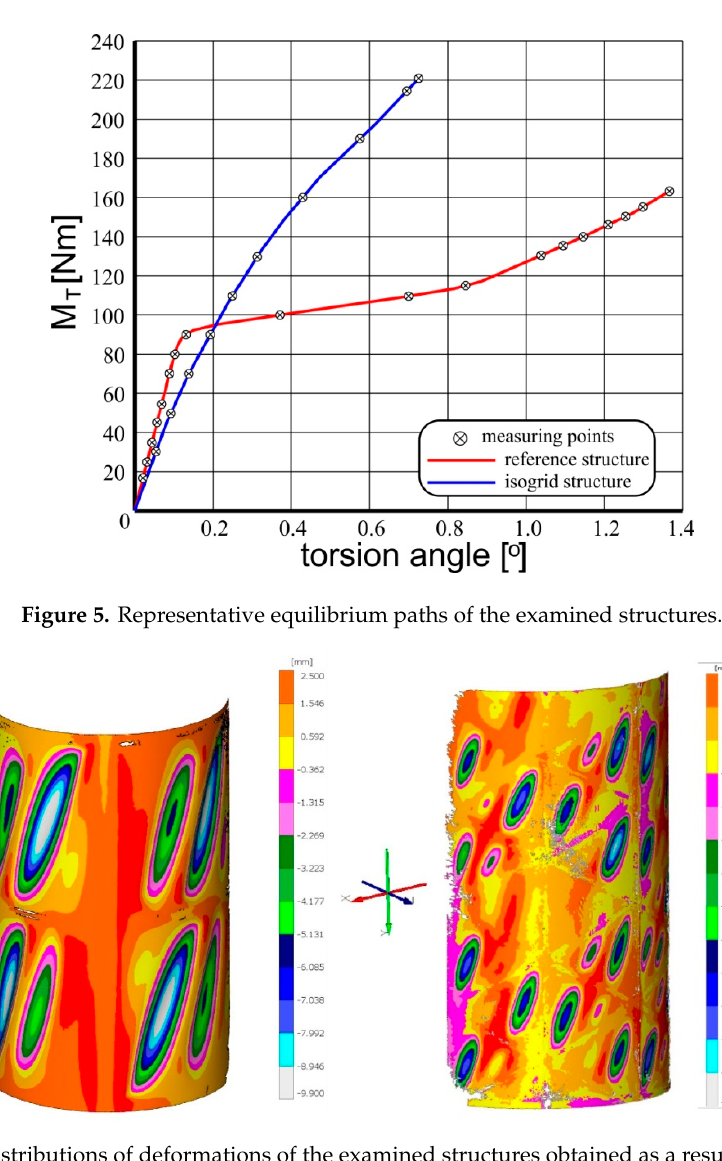
Figure 6. Distributions of deformations of the examined structures obtained as a result of scanning.